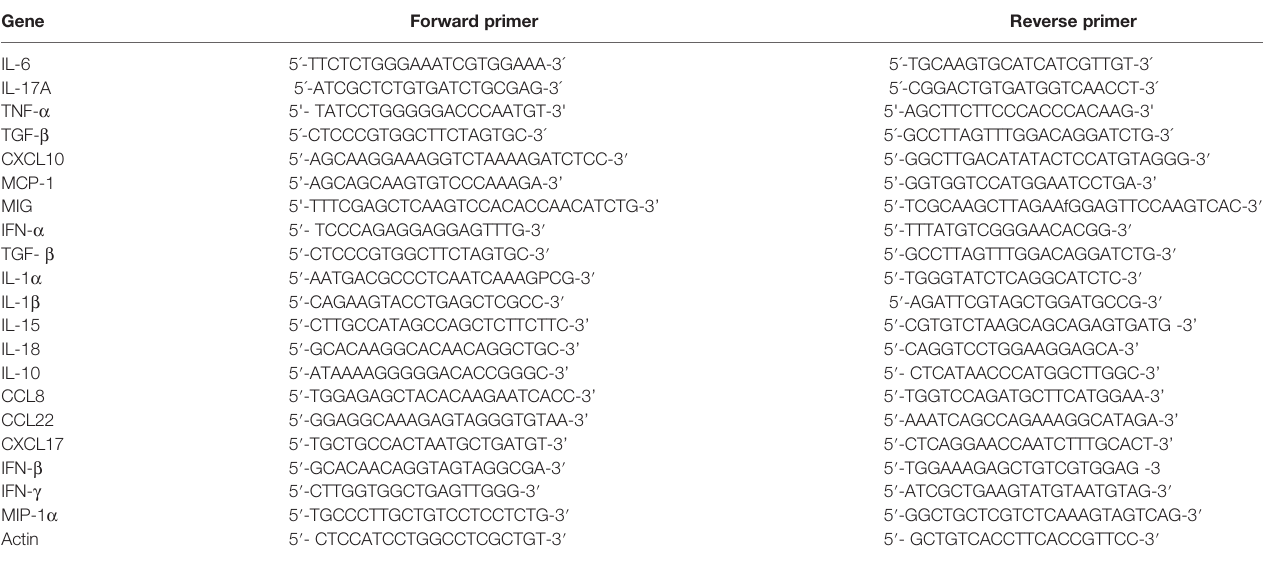
TABLE 2 | Sequences of siRNA and qPCR primers used in this study. Gene Forward